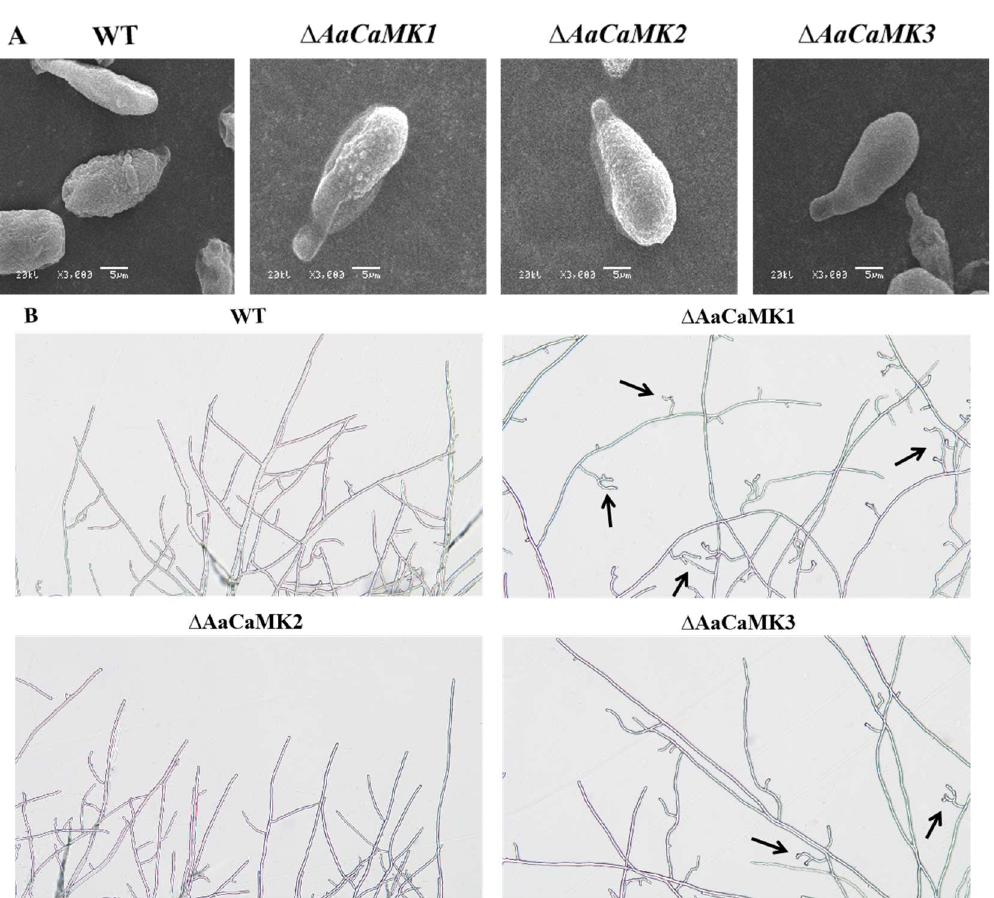
Figure 3. The spore ( A ) and hyphae morphology ( B ) of A. alternata . The black arrow indicates the abnormal branching hyphae.